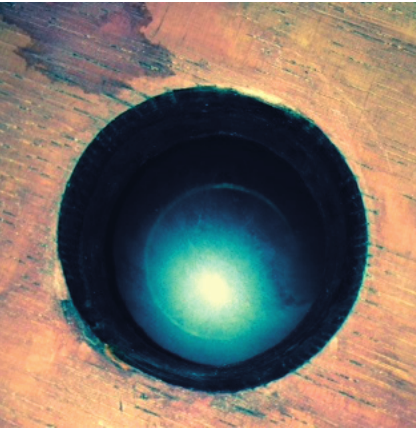
Figure 5. Continual monitoring of ullage of four barrels of wine in storage.